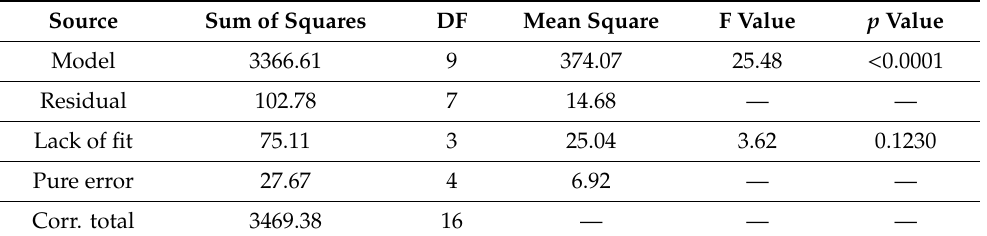
Table 4. ANOVA for the quadratic model developed for the optimization of SGN–TC nanoparticles. Source Sum of Squares DF Mean Square F Value p Value Model